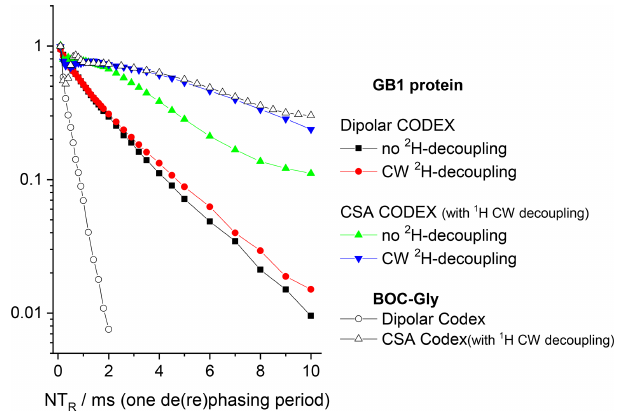
Figure 11. Signal intensity (COS component) at short mixing time (1ms) in 15 N CODEX experiments as a function of NT R in GB1 protein and BOC glycine samples. MAS 20kHz, t 13 ◦ C, 1 H and 2 H CW decoupling strengths during the de(re)phasing periods 130 and 45kHz,